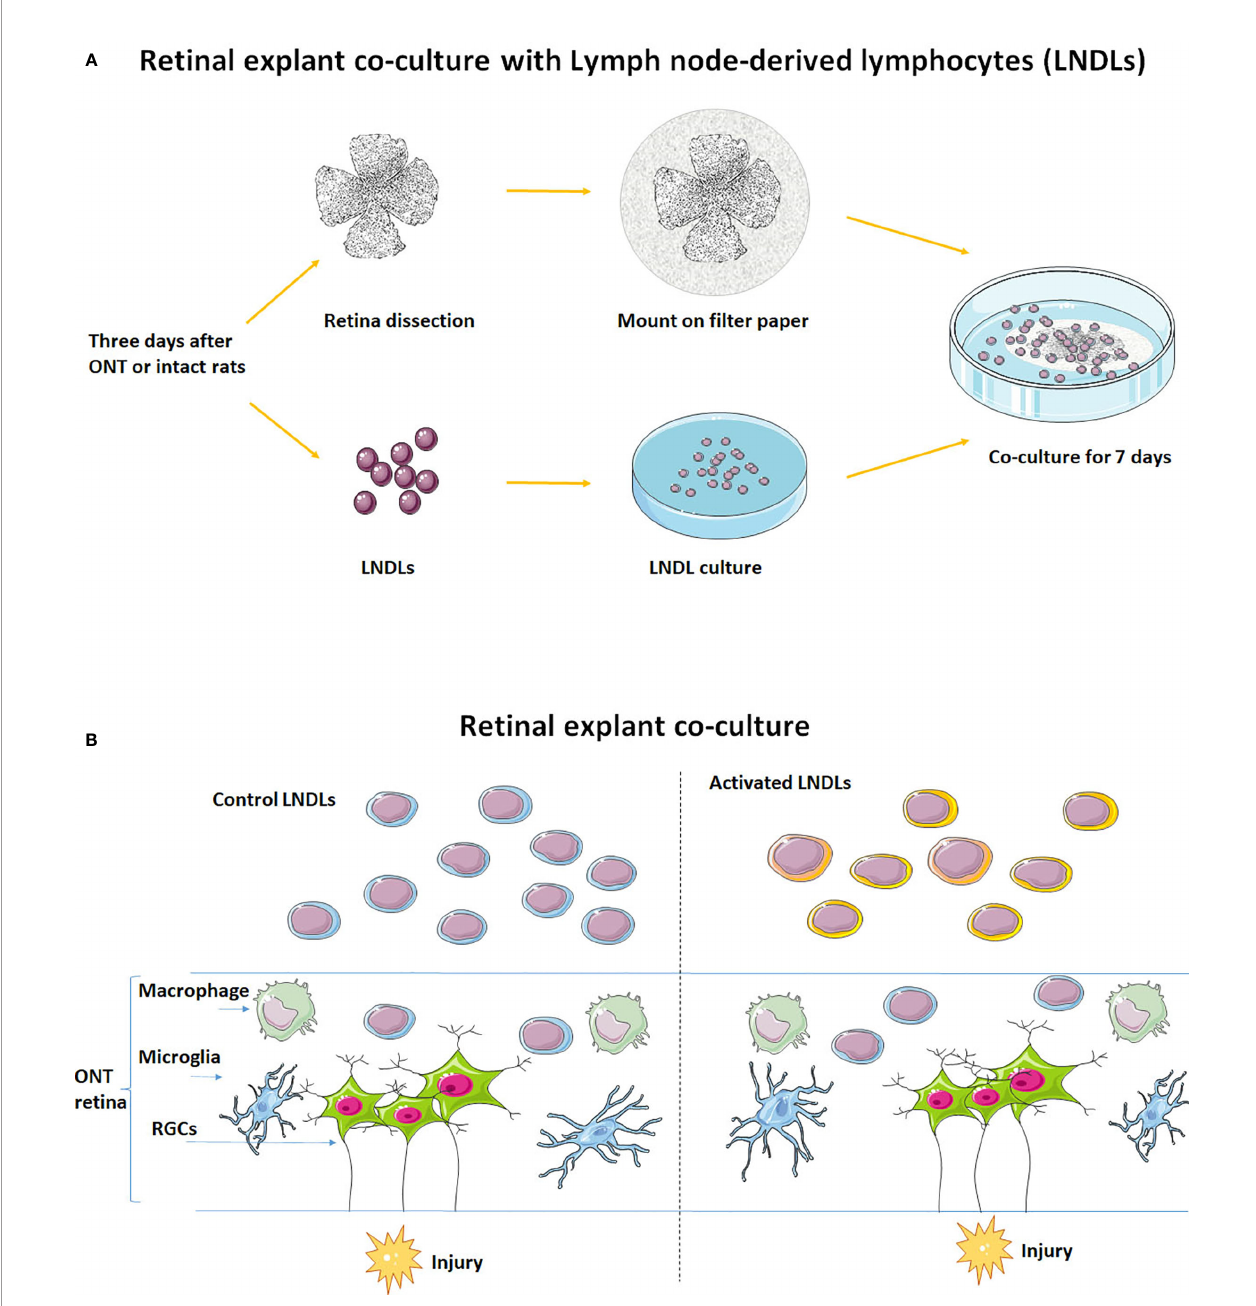
FIGURE 1 | Schematic of the in vitro retinal explant and lymphocyte co-culture system. (A) Recruitment of LNDLs of F344 rats at the 3 rd day after ONT and co- culture with retinal explant for 7 days. (B) Illustration of co-culture of rental explant and